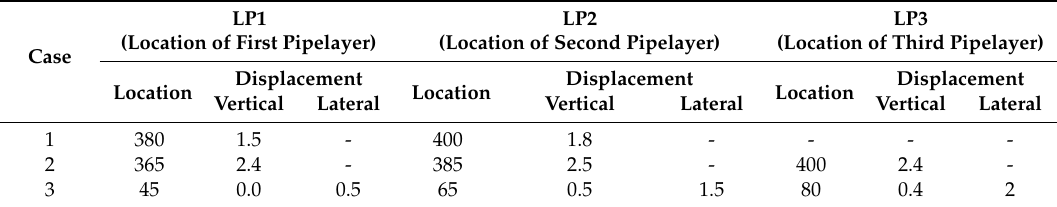
Table 2. Case examples of the segmental pipeline